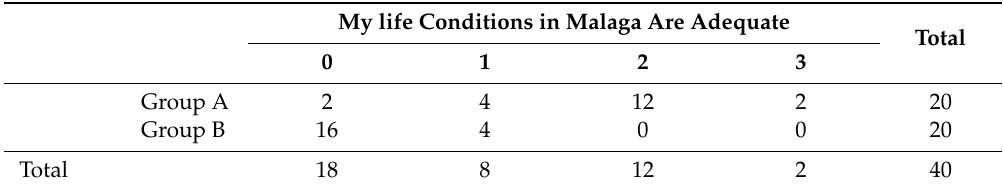
Table 11. E ff ect of the learning group in the subjective evaluation of life conditions in Malaga *.